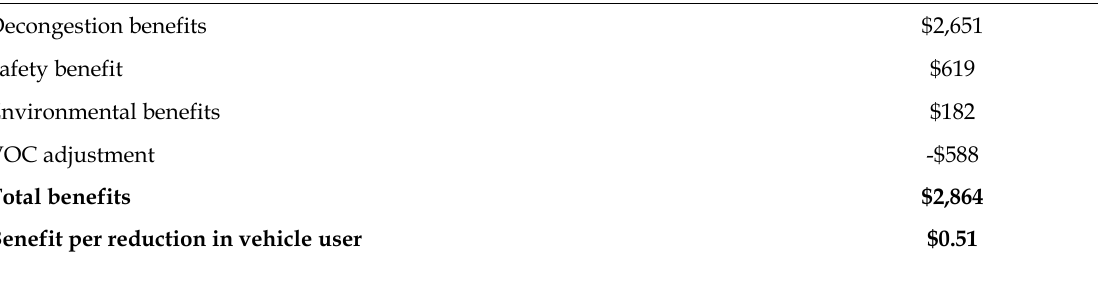
Table 4. Benefits due to reduction of driving (September 2021 dollars, per average